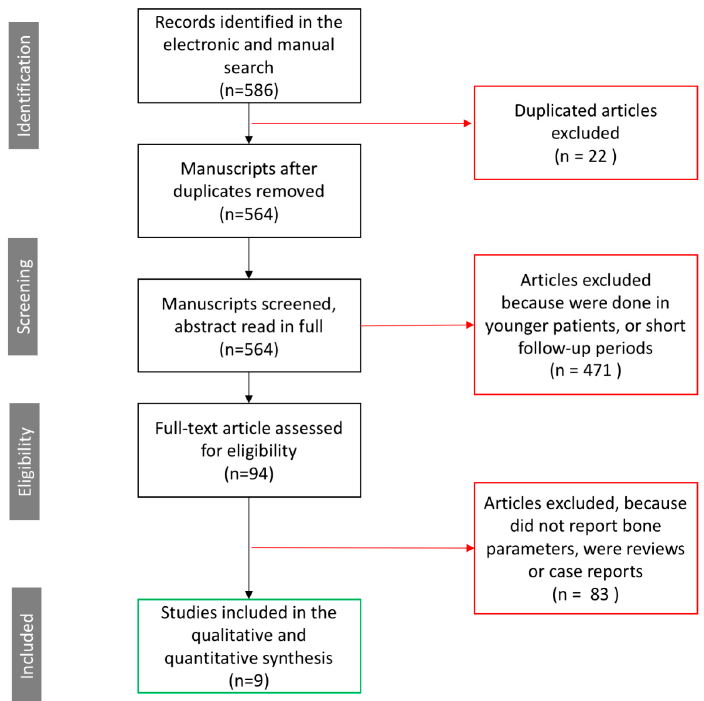
Figure 1. The Preferred Reporting Items for Systematic Reviews and Meta-Analyses (PRISMA) workflow. From the initial 586 articles, only nine articles fulfilled the inclusion criteria and were considered for this systematic review.